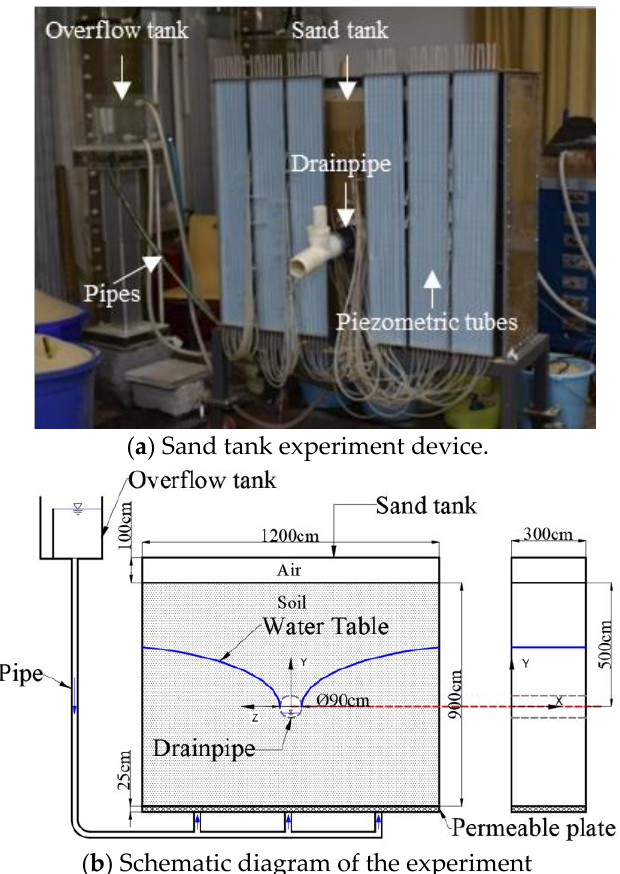
Figure 2. Schematic representation of the sand tank experiment.